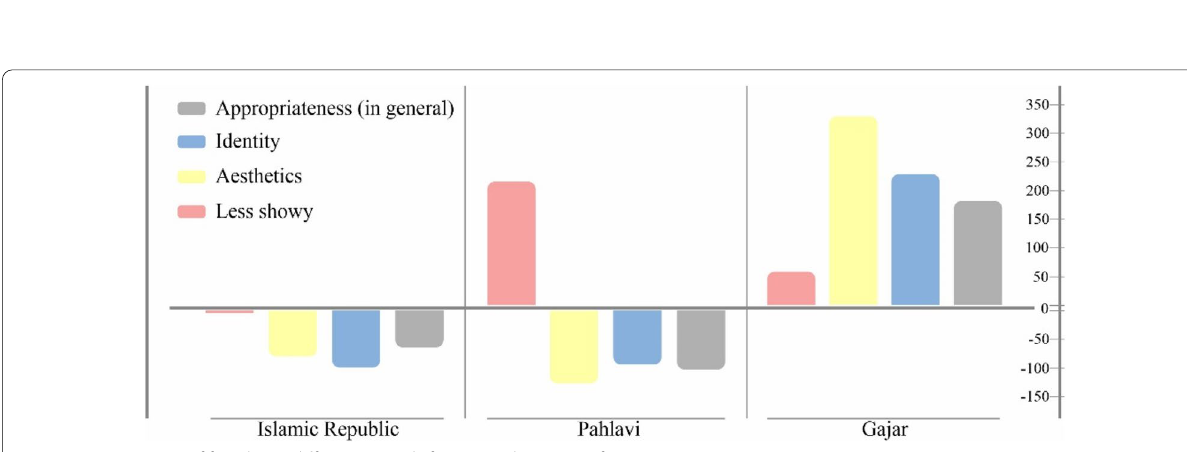
Fig. 10 Comparison of façades in different periods from people’s point of